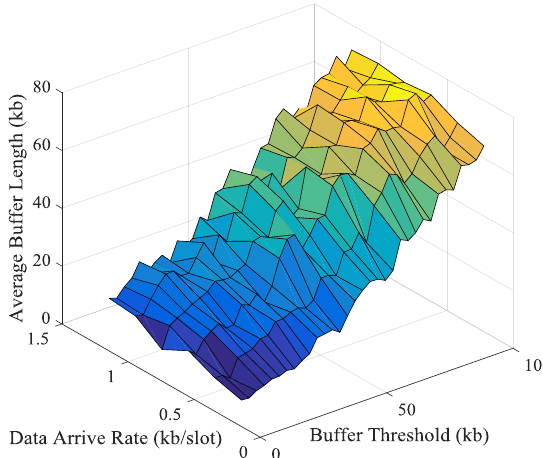
Figure 31. Simulation results of the impact of buffer threshold and data arrival rate on the average buffer